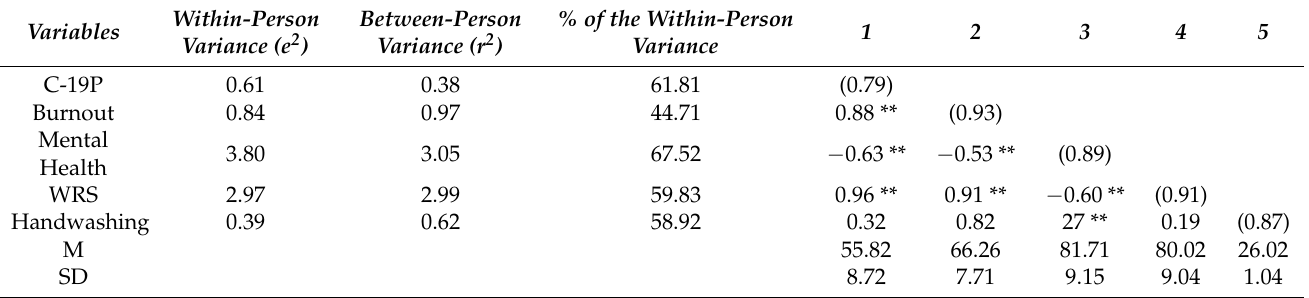
Table 4. Variance estimates, means, standard deviations, and intercorrelations